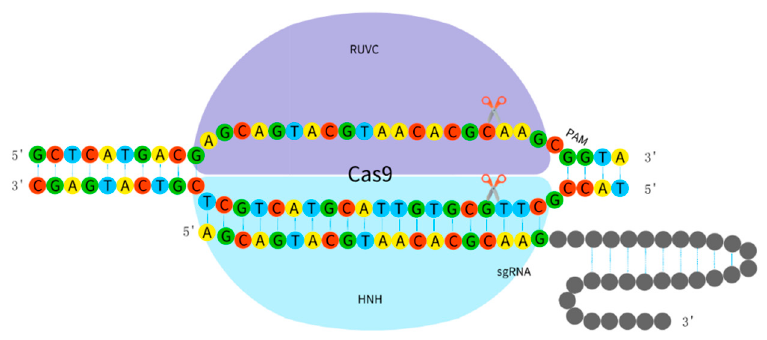
Figure 3. The schematic diagram of CRISPR/Cas9.